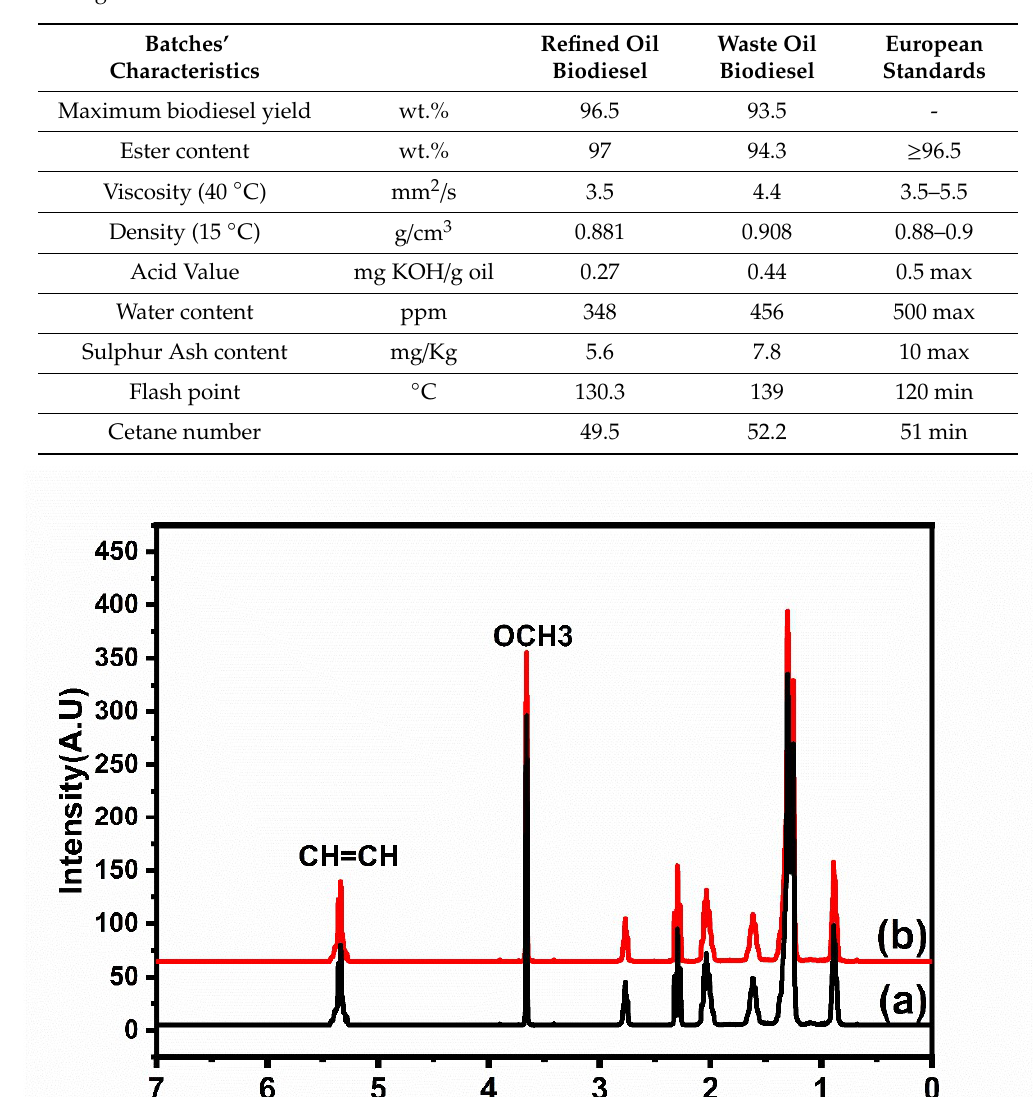
Table 2. Physico-chemical properties of biodiesel samples obtained from the refined and waste cooking oils.